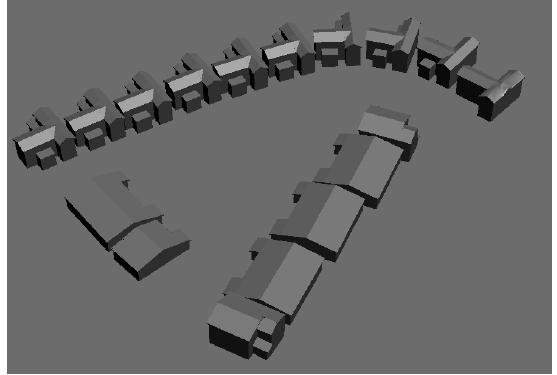
Figure 9. Building geometry